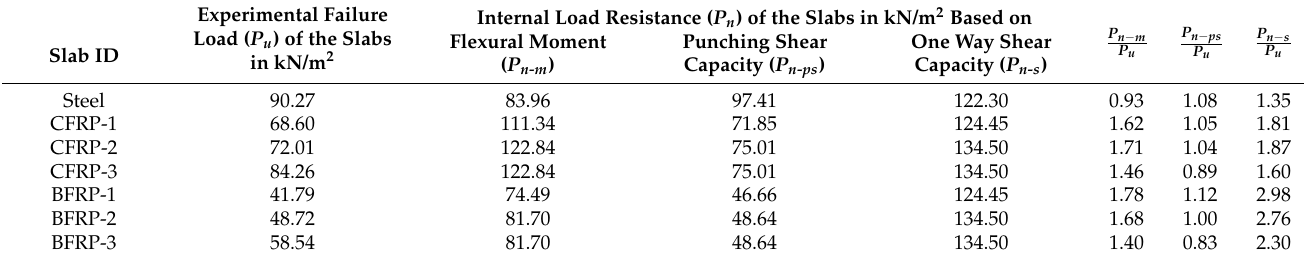
Table 10. Experimental failure load and internal capacities of the RC